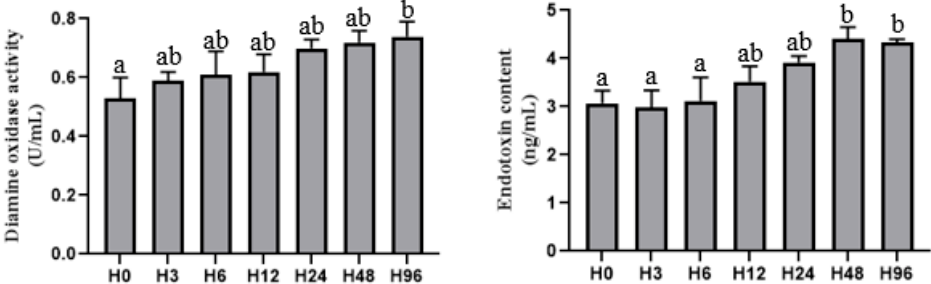
Figure 1. Effect of dietary histamine content on the intestinal permeability-related index in the serum of the hybrid grouper. Values are means ± SE of three replications. Different superscript letters in the bars indicate a significant difference among treatments by Tukey’s test ( p < 0.05).